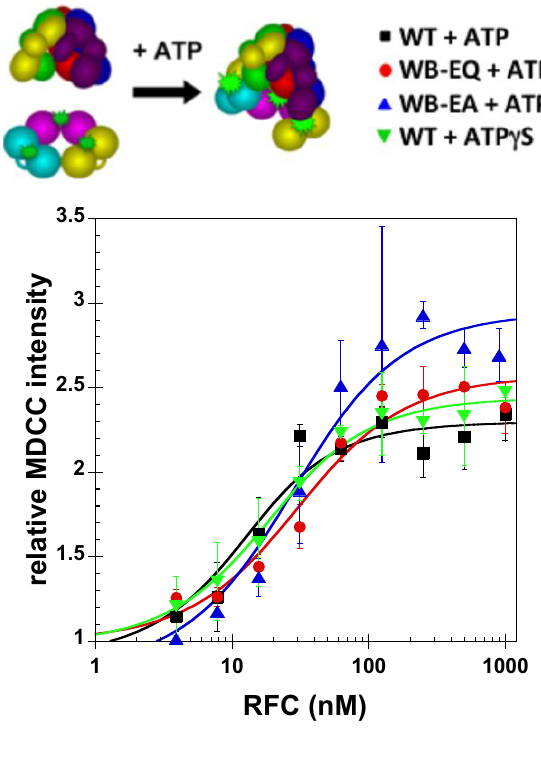
Figure 2. Clamp binding activities of WT RFC and Walker B mutants. Binding of WT RFC to PCNA-MDCC was measured in the presence of ATP (black squares) or ATP (cid:534) S (green inverted triangles), and binding of WB-EQ (red circles) and WB-EA mutants (blue triangles) to PCNA-MDCC was measured in the presence of ATP. The relative intensity of MDCC at 470 nm is plotted as a function of RFC concentration for solutions containing 10 nM PCNA-MDCC and 0.5 mM ATP or ATP (cid:534) S. Data shown are the average of three independent experiments. Error bars represent standard